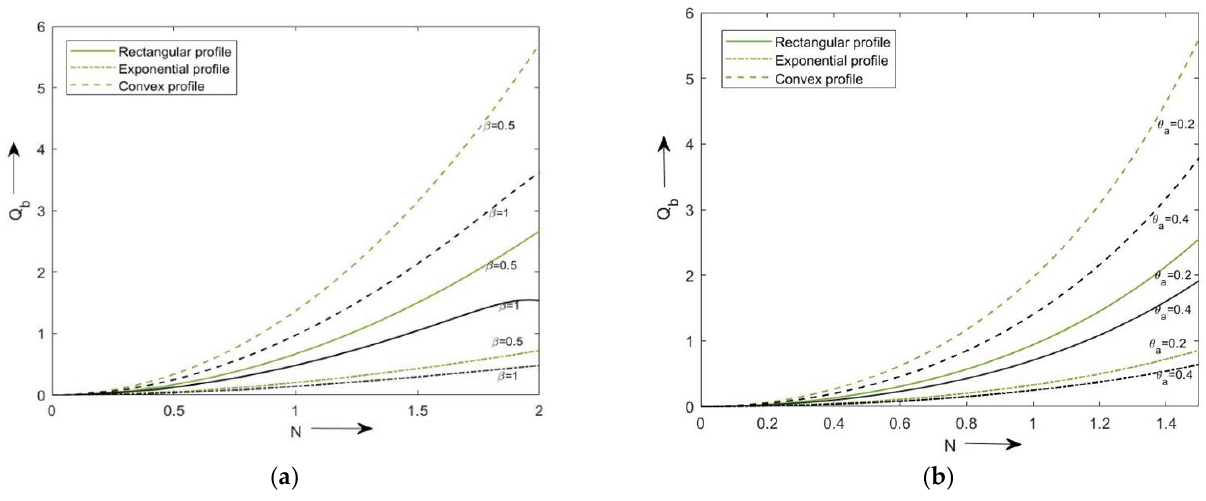
Q with N for several assigned values of  . ( b ) Variation of b Q  with N for several assigned values of  . ( b ) Variation of b . a  . a